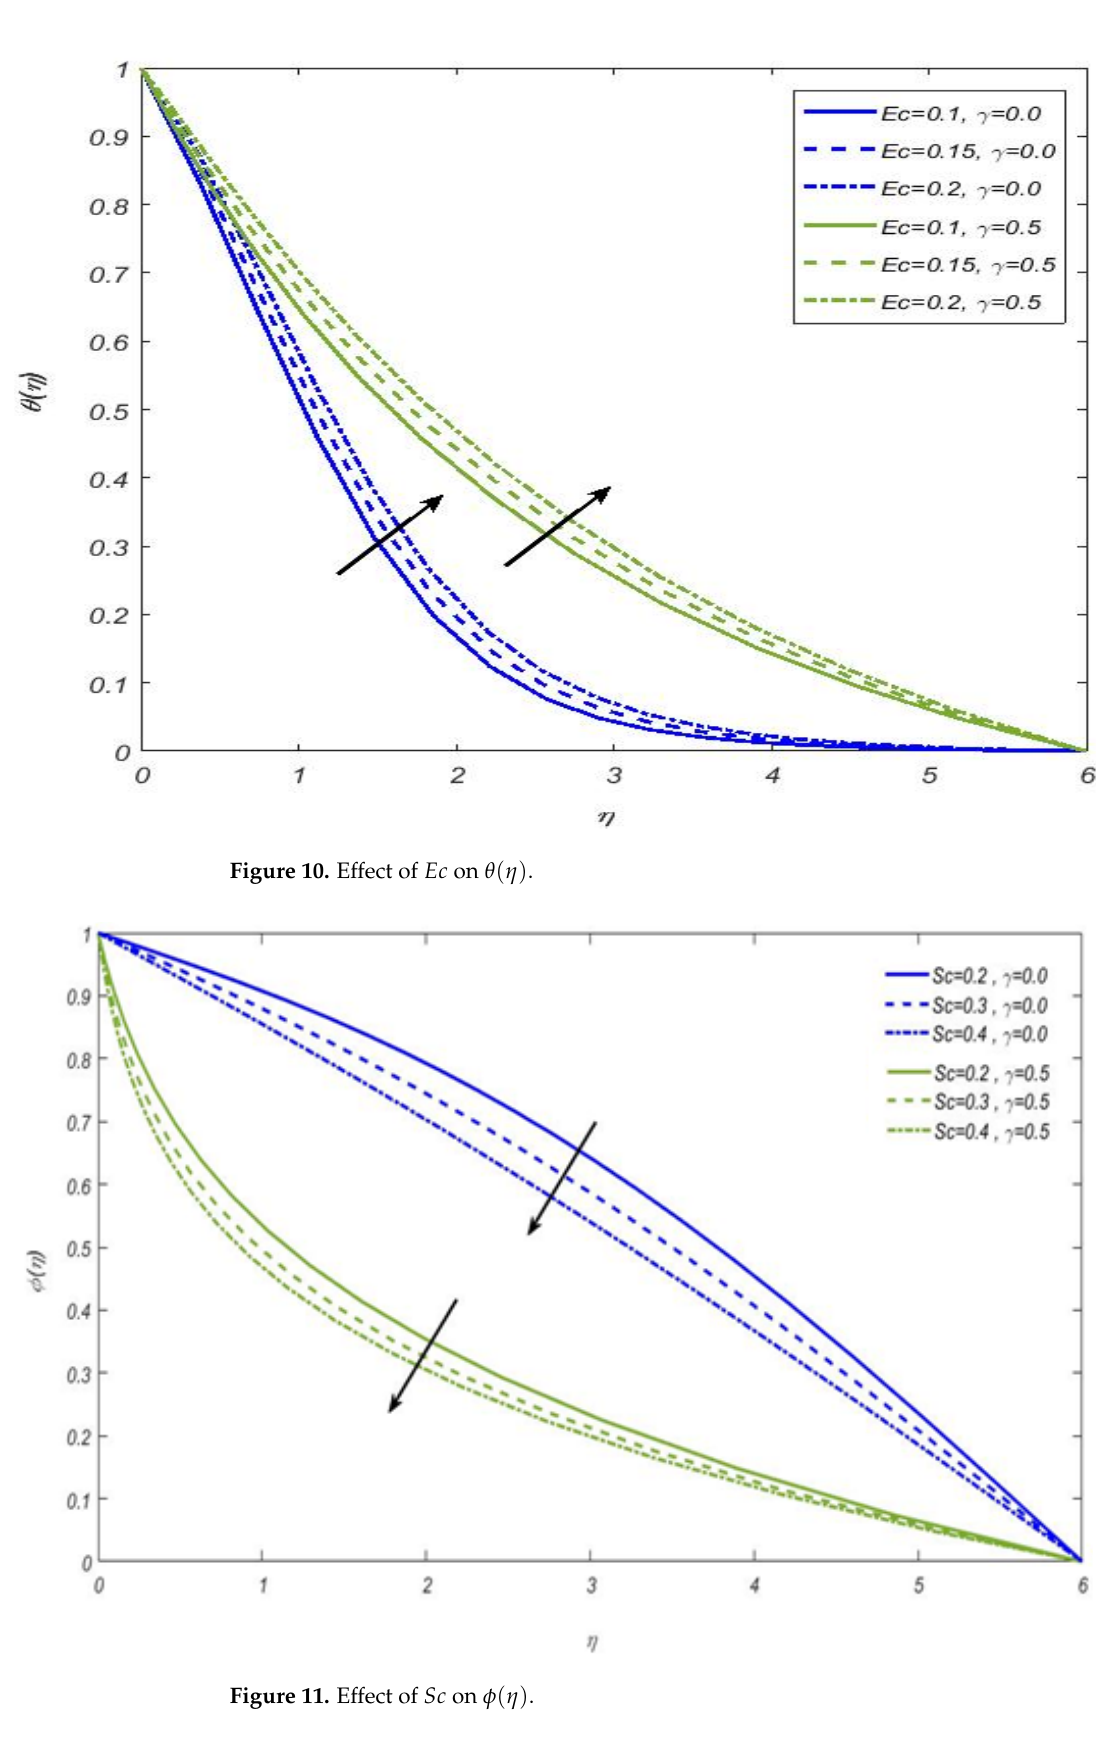
Figure 9. Effect of